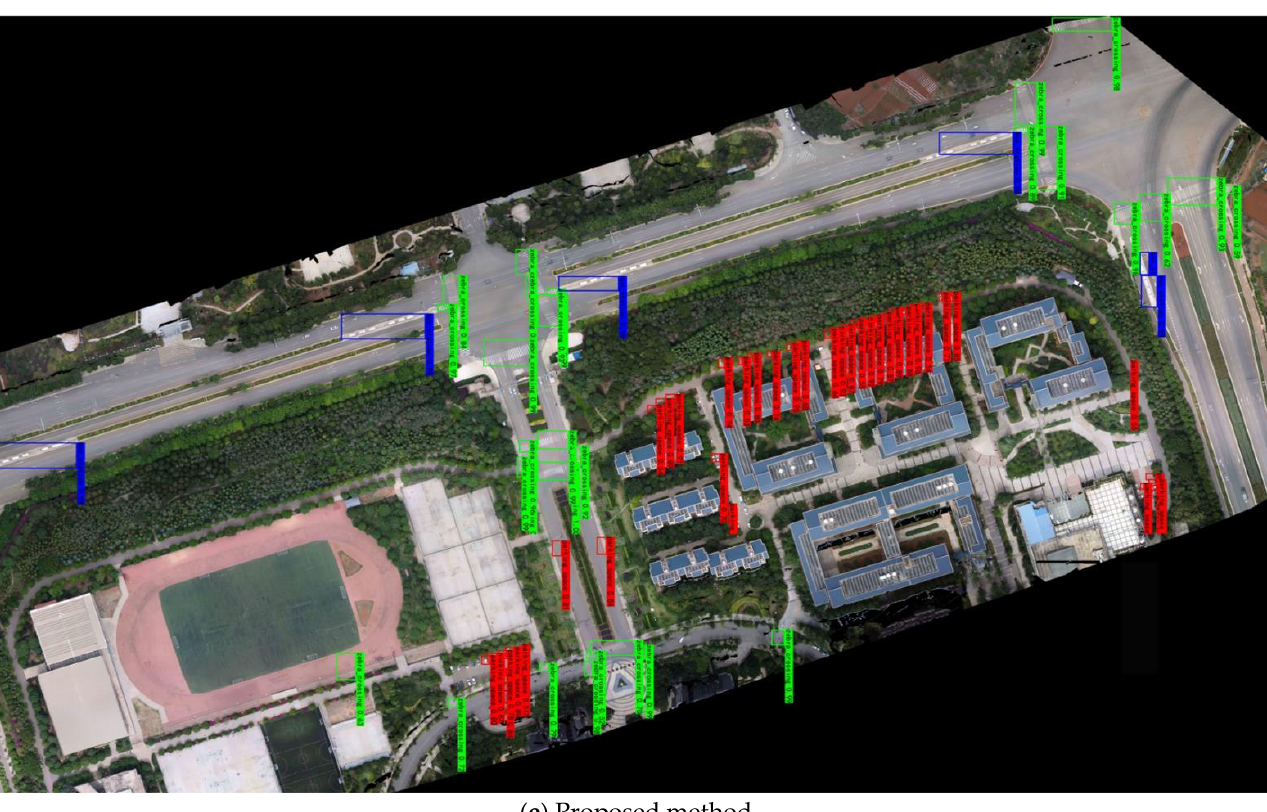
Figure 7. Predicted results of the ablation experiment in a large and complex scenario. ( a ) YOLOv4 with k-means; ( b ) YOLOv4 with mosaic; ( c ) YOLOv4 with SE attention mechanism; ( d ) YOLOv4 with CBAM attention mechanism; ( e ) proposed method. Table 5. Predicted results of ablation experiments in large complex scenarios.